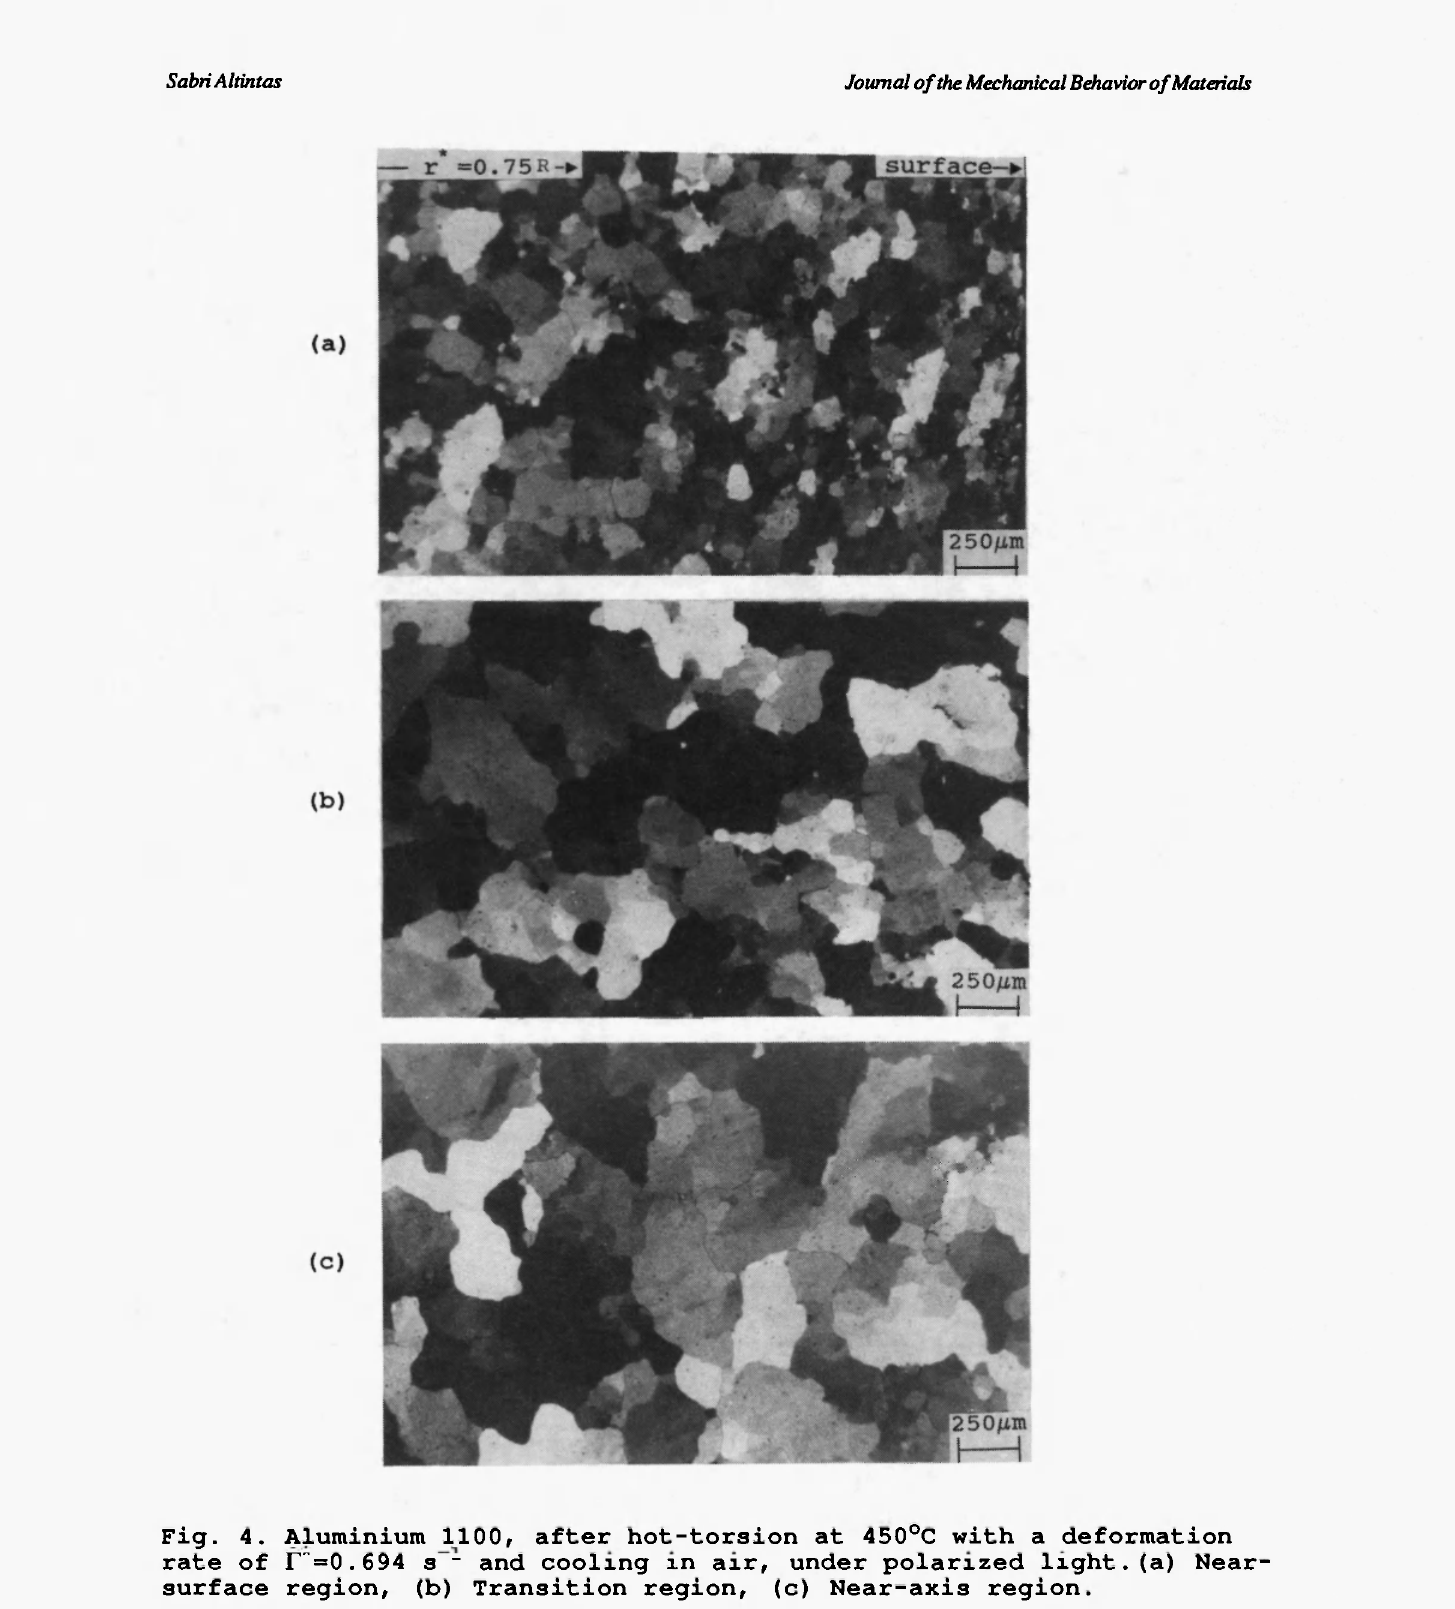
Fig. 4. Aluminium 1100, after hot-torsion at 450°C with a deformation rate of Γ =0.694 s and cooling xn air, under polarized light, (a) Near- surface region, (b) Transition region, (c) Near-axis region.